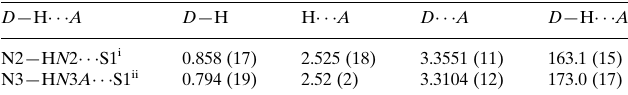
Hydrogen-bond geometry (A˚ , (cid:2)